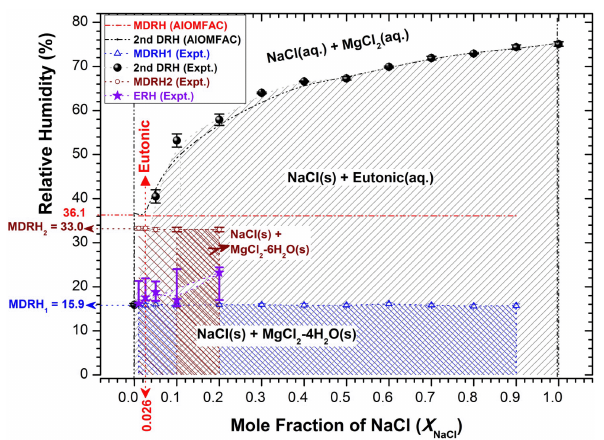
Figure 7. Measured MDRHs (MDRH 1 = 15.9 ( ± 0.3)% ⇒ open blue triangles; MDRH 2 = 33.0 ( ± 0.5)% ⇒ open brown circles) and the second DRH (closed black circles) and calculated MDRH (dotted red line) and the second DRHs (dash-dotted black curve) from the AIOMFAC, plotted as a function of the mole fraction of NaCl in NaCl–MgCl 2 mixture particles. The phase notations shown in parentheses are s = solid and aq = aqueous. The brown shaded portion is where particles with three types of transitions (types A, B, and C as in text) were observed for X NaCl = 0.1 and 0.2. The dense and light brown shaded patterns indicate the high and low en- countering frequencies of type B and C particles, respectively. The average and range of ERHs observed during the humidification pro- cess for type B particles are represented by purple stars and bars, respectively.